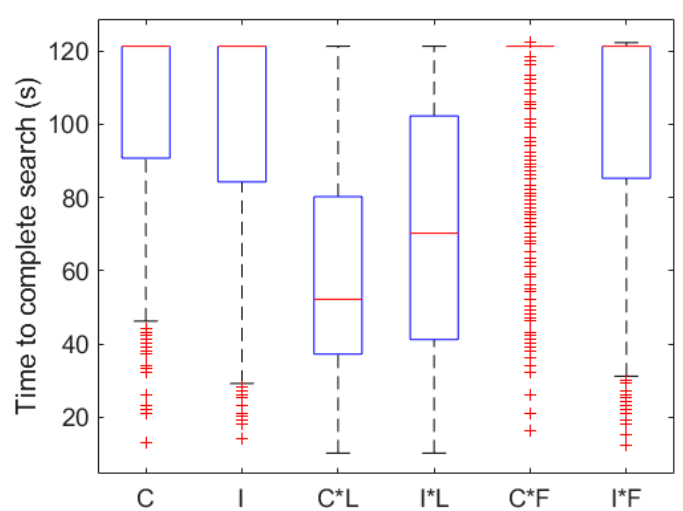
Figure 7. Summary statistics for different search algorithms applied to lobster antennule and leg chemosensors and mechanosensors. C = Concentration strategy, I = Intermittency, C*L = Concentration and Legs, I*L = Intermittency and Legs, C*F = Concentration and Flow, I*F = Intermittency and Flow. The central red line is the median, box edges are the 25th and 75th percentiles, whiskers extend to the farthest points that are not outliers, and outliers are red crosses.